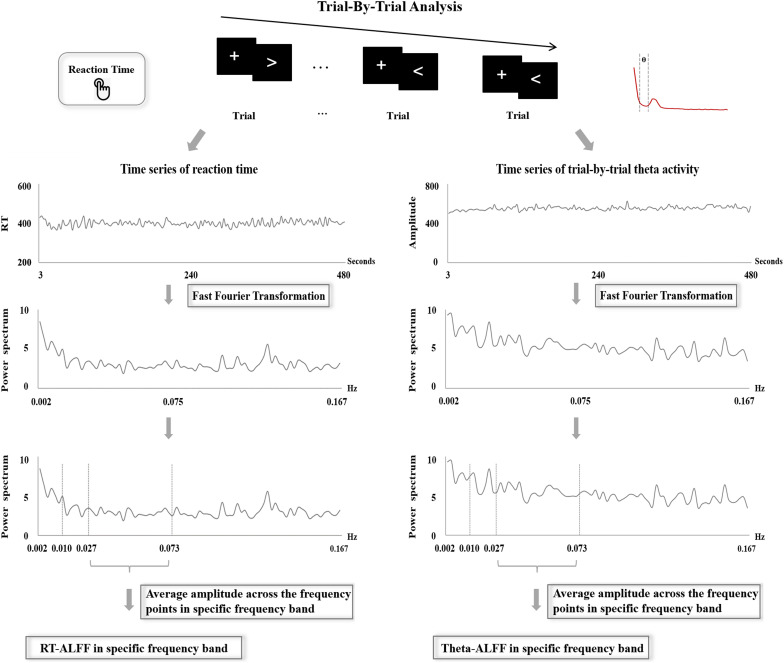
The procedure of the frequency-dependent analysis of reaction time and trial-by-trial theta activity.